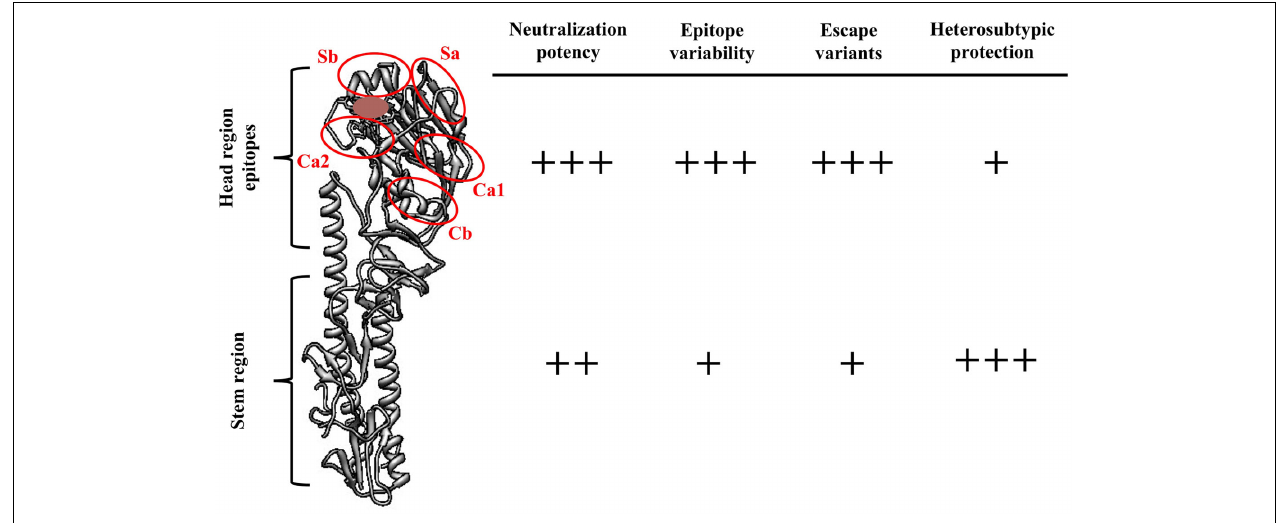
epitopes (red circles) and their localization close to the receptor-binding domain (brown).The number of ( + ) signs was arbitrarily determined. Figure was prepared using Chimera (Pettersen et al.,